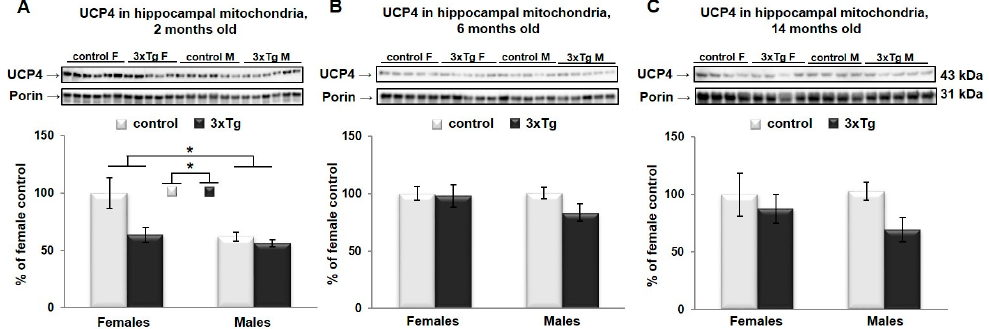
Figure 6. UCP4 protein levels in cortical mitochondria. Representative WBs for UCP4 and their relative quantification normalized to porin protein levels in the cortical mitochondria from 3xTg female and male mice at 2 ( A ), 6 ( B ) and 14 months of age ( C ). Data were analyzed by two-way ANOVA, and results are expressed as percent change from control mean of 100% ± SEM of n = 4–6 animals per group. UCP4 protein levels were significantly different as a function of sex (* p < 0.05), regardless of age, and of genotype at 6 and 14 months (* p < 0.05 and ** p < 0.01 respectively), with a significant interaction effect between sex and genotype at 14 months (* p < 0.05). Simple main effects in this age group revealed that control males had significantly less UCP4 than females (** p = 0.001) and that 3xTg females had significantly less relative to C57BL/6 females (** p = 0.001). In hippocampal mitochondria, two-way ANOVA analysis revealed that UCP4 protein levels were significantly different as a function of sex (UCP4 protein levels were higher in females, * p < 0.05, Figure 7A) and as a function of genotype (UCP4 protein levels were lower in 3xTg animals, * p < 0.05, Figure 7A) only at 2 months, with a trend towards a significant interaction effect between sex and genotype ( p = 0.067).